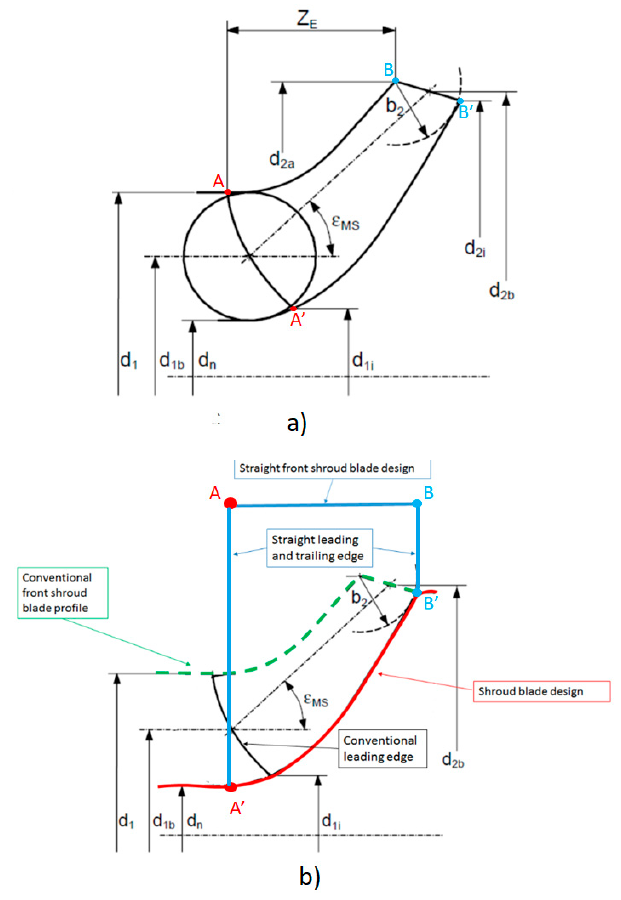
Figure 16. ( a ) Semi-axial impeller dimension [20]; ( b ) modified semi/axial impeller for lead pump